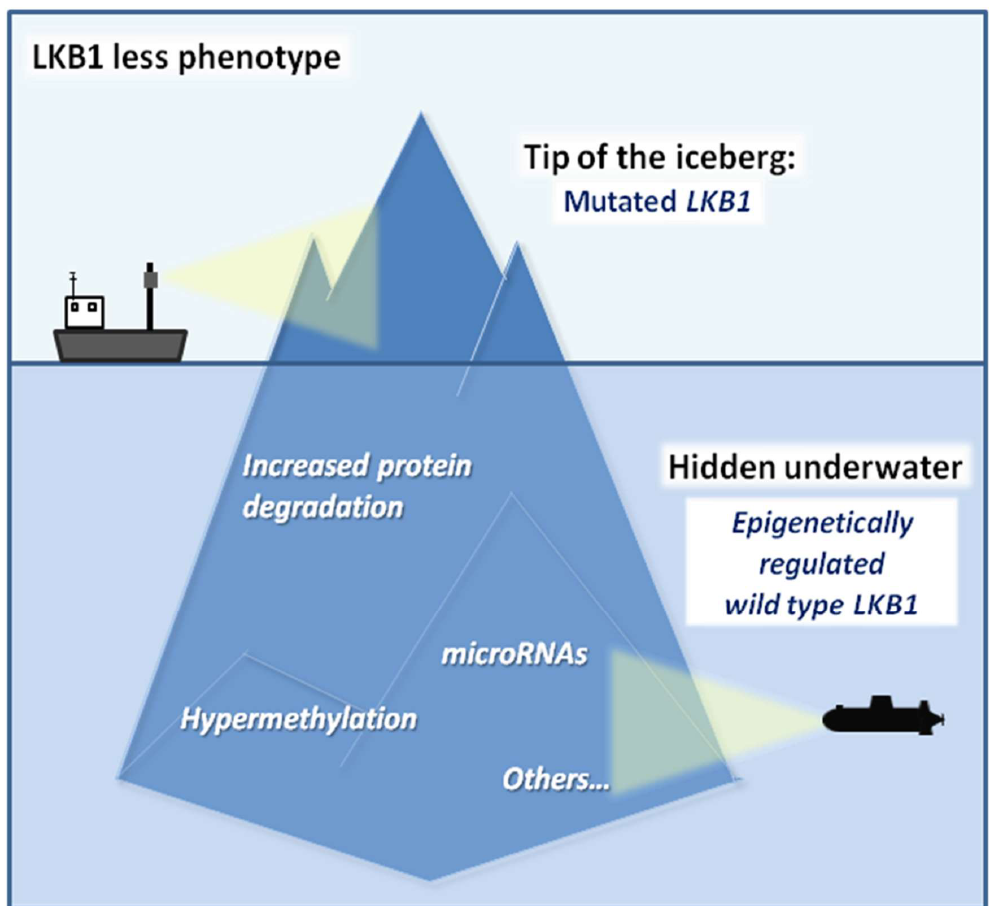
Figure 3. Schematic representation of the current knowledge on the LKB1less phenotype. The tip of the iceberg represents LKB1 mutations. Hidden underwater, the less investigated conditions that led to the LKB1less phenotype in wild-type LKB1 patients (hypermethylation of the promoter, non-coding RNAs, increased protein degradation, etc.) are waiting to be further investigated.